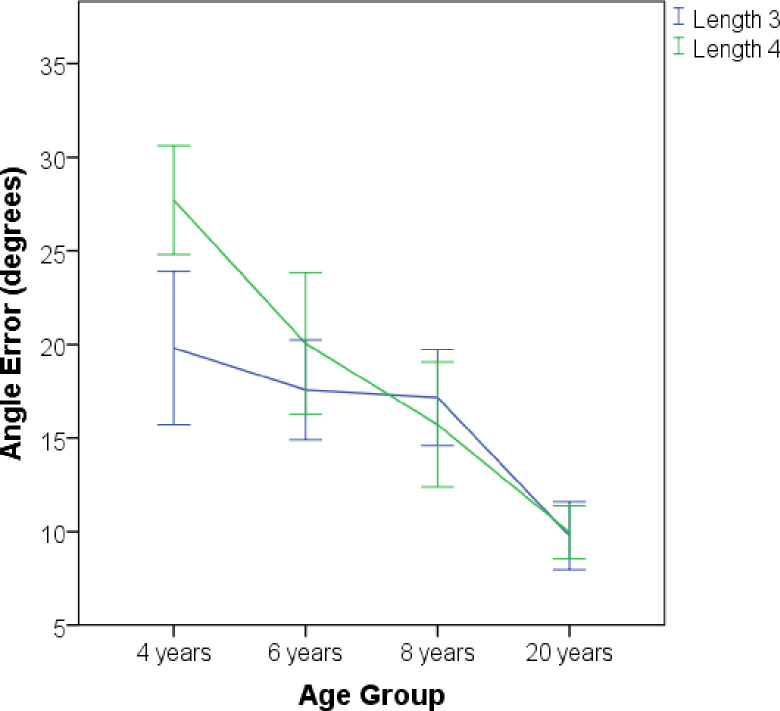
Mean error for angle.Error bars represent the standard error of the mean.